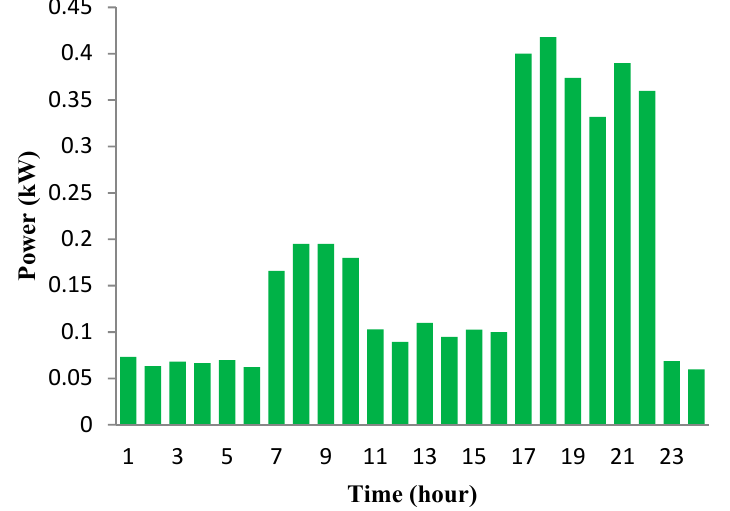
Figure 6. Predicted load profile of a house during mid-peak hours over a 24 h horizon .